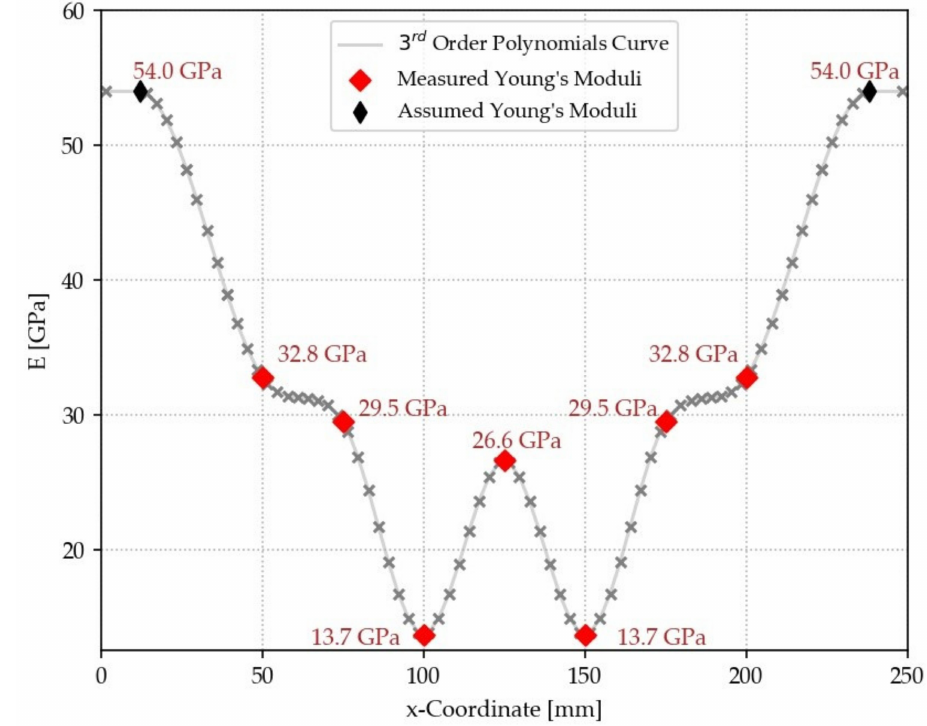
Figure 7. Variation of residual Young’s modulus with respect to the